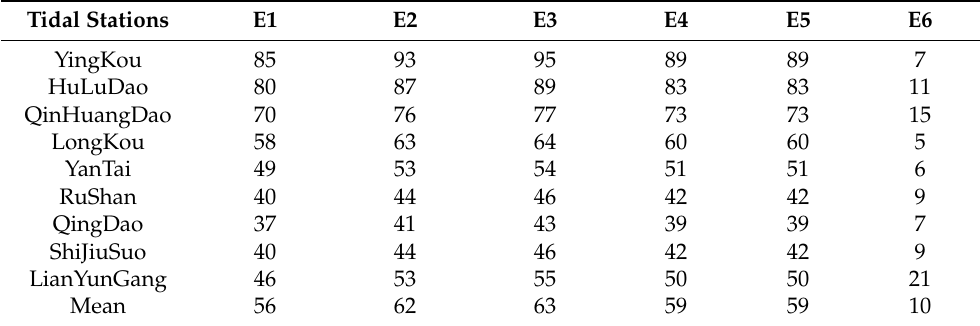
Table 5. Root mean square errors between the simulated storm surge levels and observations at 9 tidal stations during Typhoon 7008 (unit: cm).